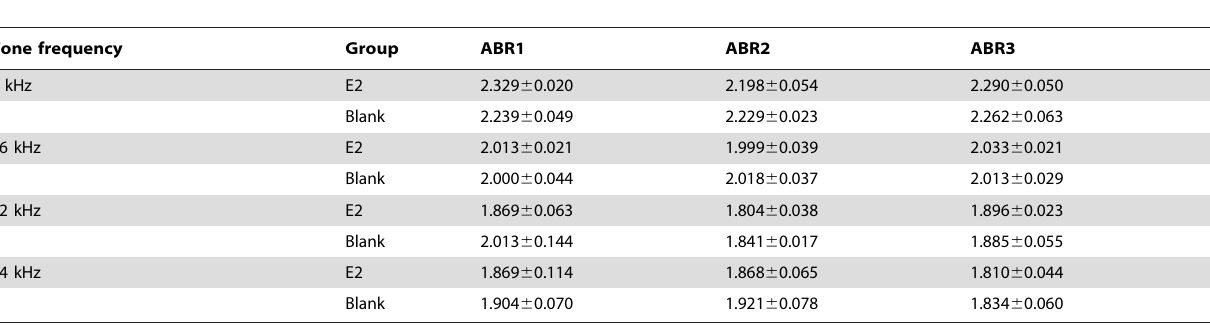
Table 6. Estradiol effects on tone-evoked peak I ABR latencies measured 10 dB above each animal’s threshold.